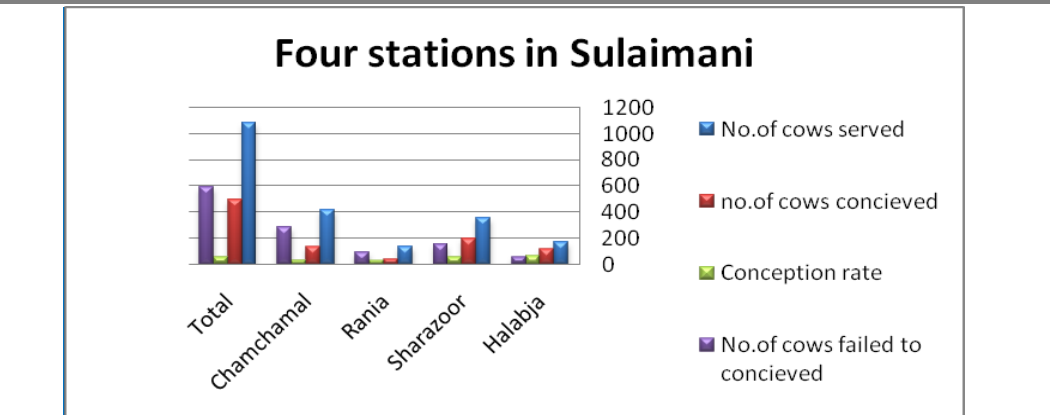
Figure, 1: The conception rate of cows and calf sex in different AI stations of Sulaimani region. Table, 2: The conception rate calf sex in different seasons for Halabja station.